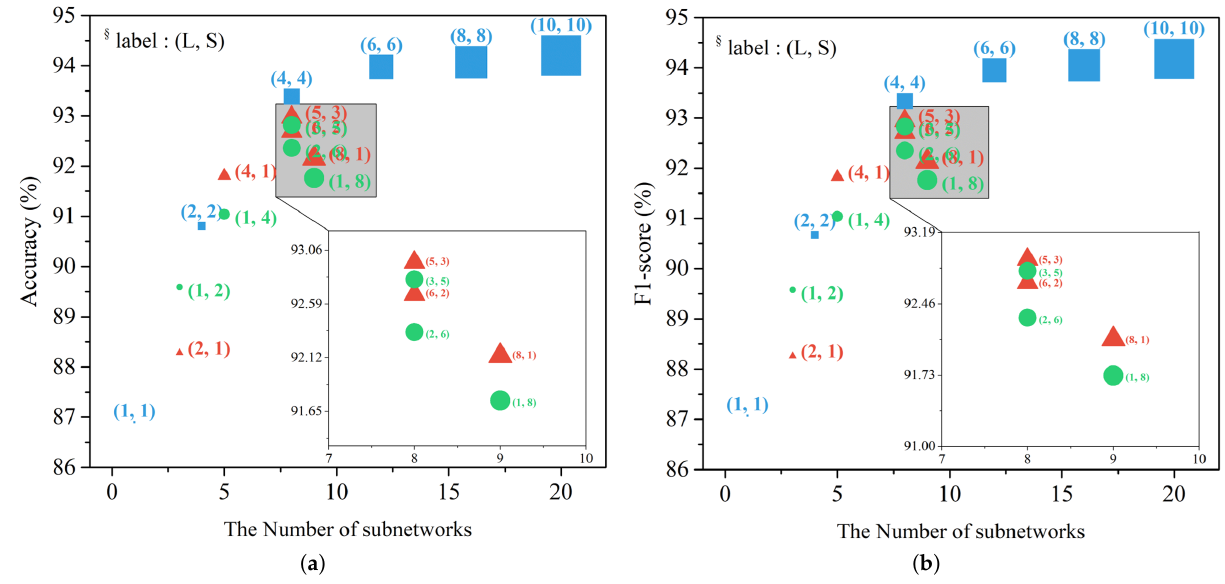
Figure 10. Performance comparison according to model structure parameter changes: ( a ) accuracy and ( b ) F1-score.